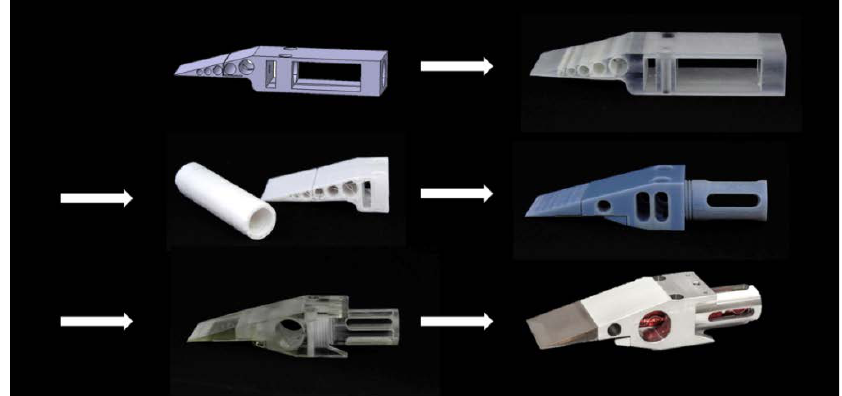
Figure 9. Design evolution from a box-shaped design to the final actuator.